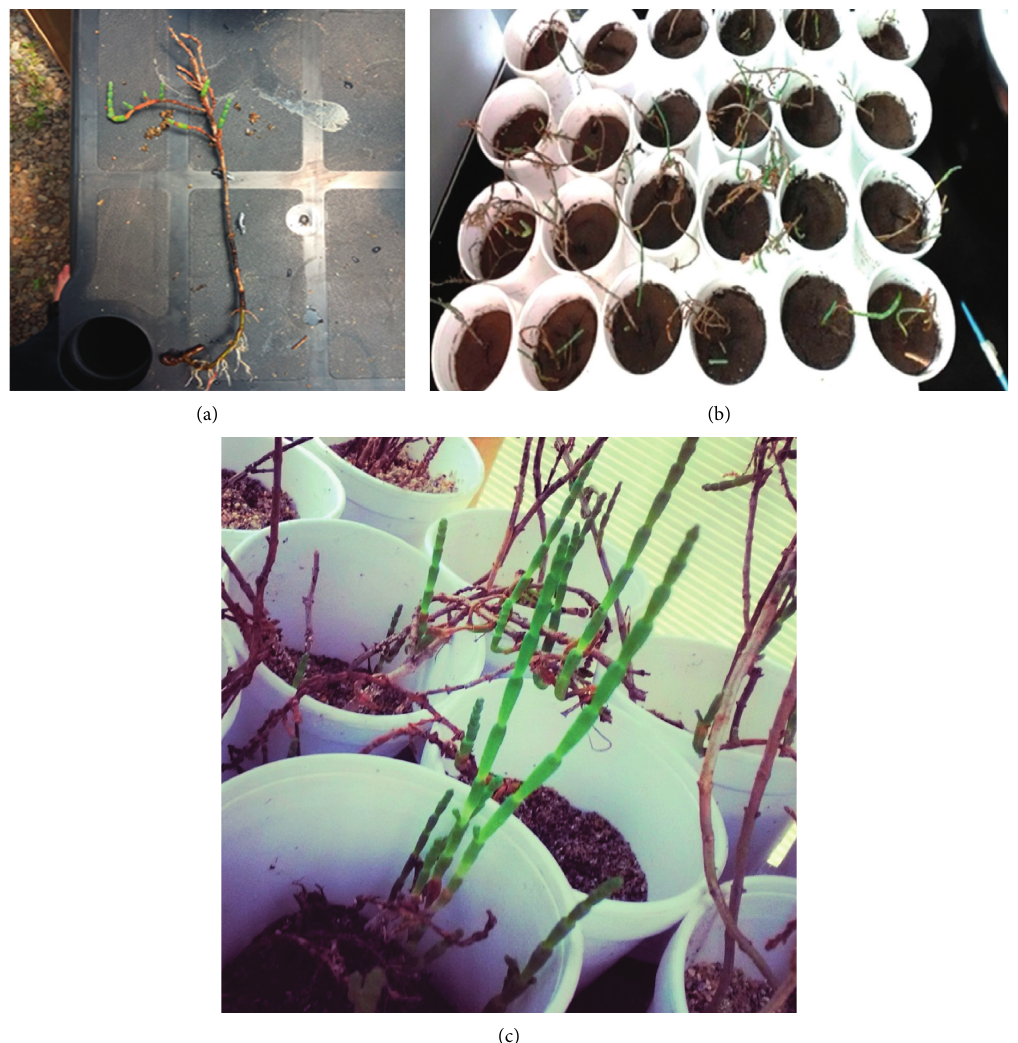
Figure 3: (a) Plant with root development in rhizome to be used in remediation. (b) Plants distributed in containers with contaminated soil. (c) Detail of growing plant with lateral budding beginning near the